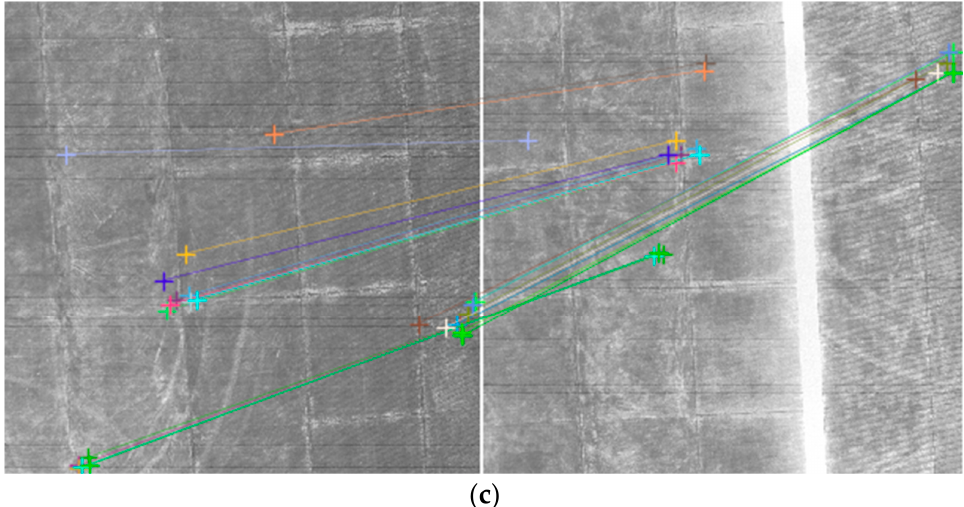
Figure 15. Experimental results of featureless remote sensing image registration. ( a ) Image registration algorithm based on geographic location information; ( b ) image registration algorithm based on SIFT; ( c ) image registration algorithm based on a neural network model. Table 8. Comparison of experiment